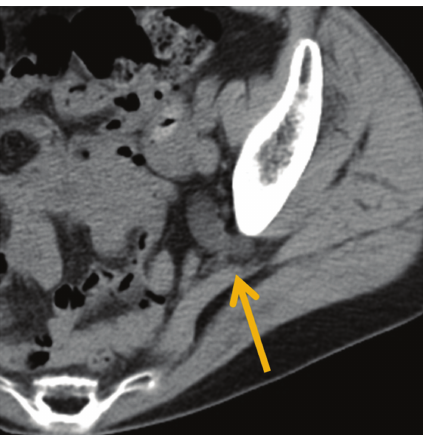
Figure 1: Computed tomography showed ureteral herniation into the sciatic foramen (arrow).